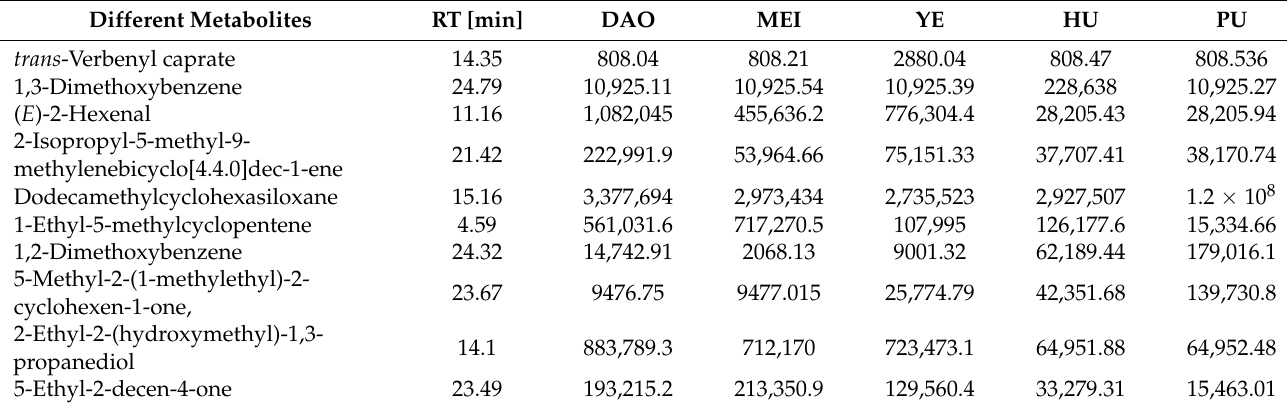
Table 3. The significant different metabolites and their relative abundance between aromatic and non-aromatic rice varieties. Different